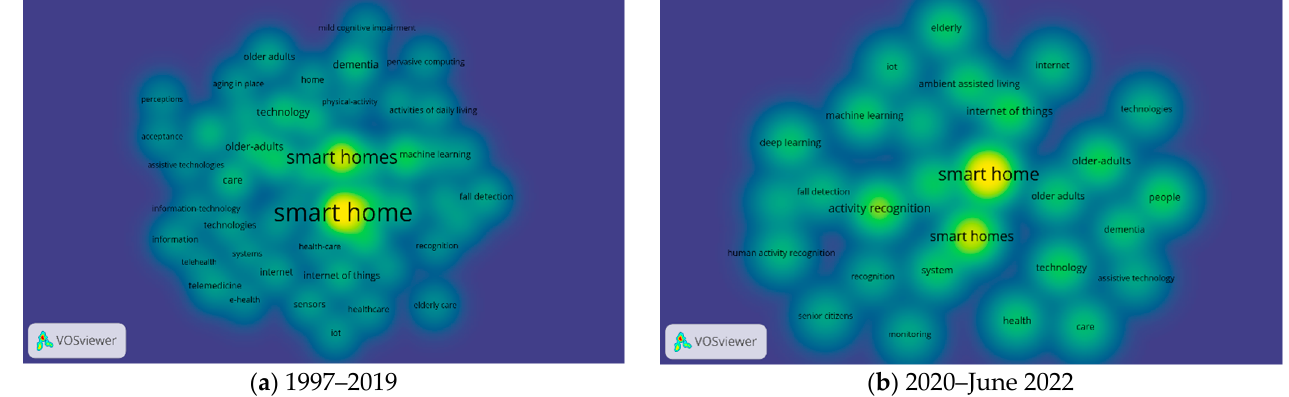
Figure 7. Distribution of SHOA research by keywords co-occurrence density map.